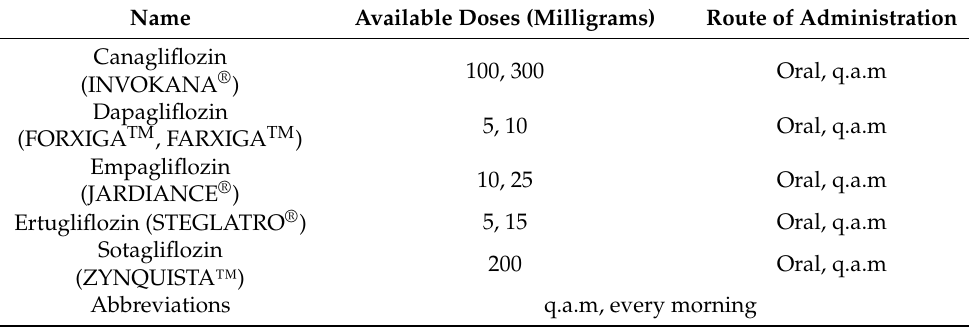
Table 1. List of the currently most used SGLT-2i in the United States and